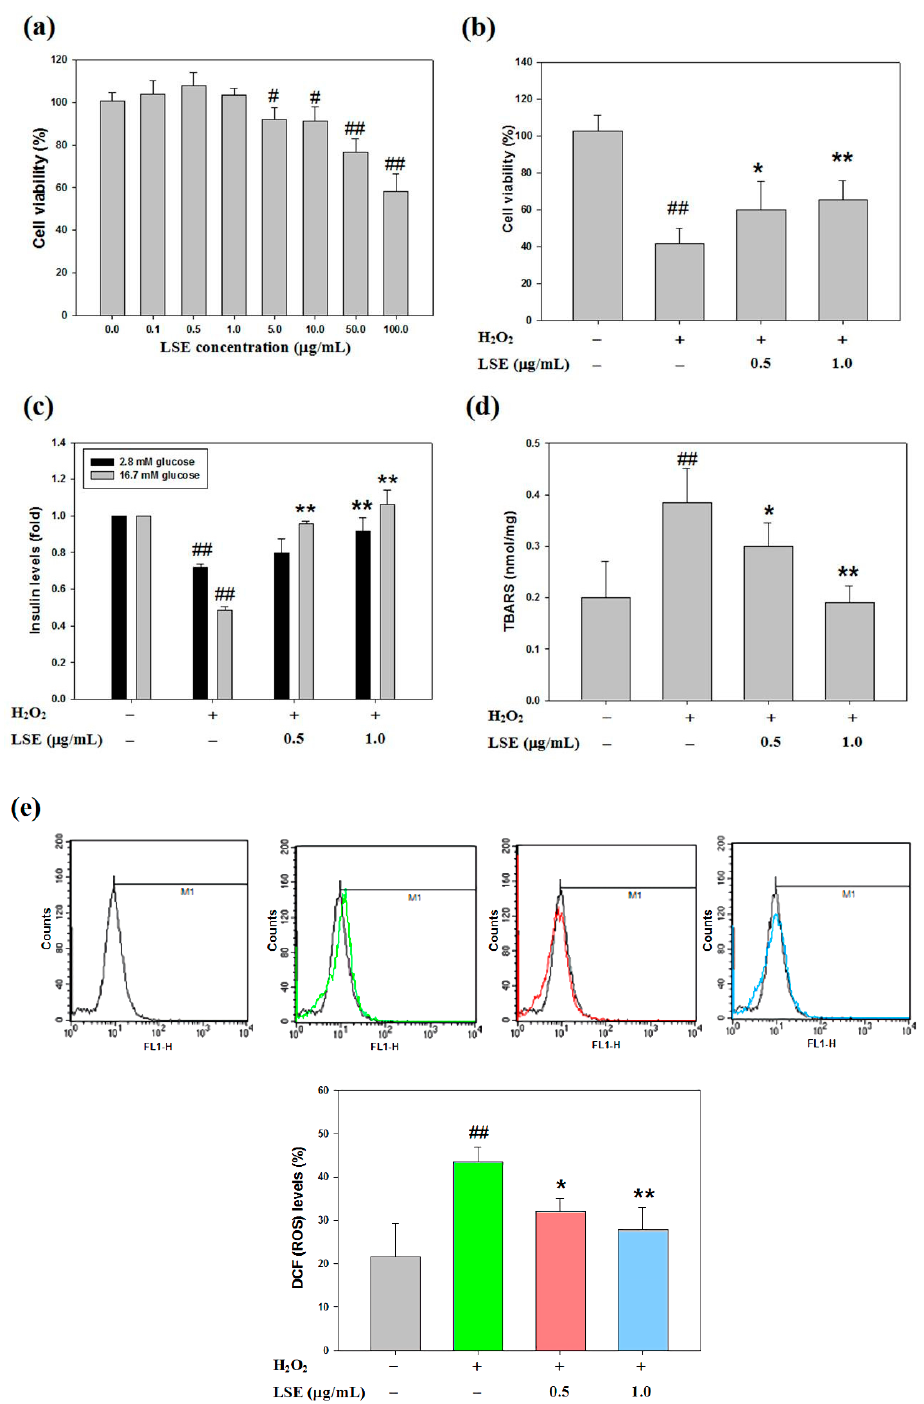
Figure 2. Effects of LSE in combination with H 2 O 2 on beta-cell viability and oxidative injury. ( a – b ) Rat pancreatic beta-cells (RIN-m5F) were treated with various doses of LSE (0–100 µg/mL) alone ( a ) or the indicated doses of LSE (0.5 and 1.0 µg/mL) in combination with 200 µM of H 2 O 2 ( b ) for 24 h. The cell viability was evaluated by the MTT method. ( c – e ) Under the same co-treatment conditions, the insulin secretion ( c ), lipid peroxidation ( d ), and intracellular reactive oxygen species (ROS) level ( e ) were assessed by measuring the glucose-stimulated insulin secretion (GSIS), thiobarbituric acid relative substance (TBARS), and dichlorofluorescein diacetate (DCFH-DA) assay, receptively. The results are represented as mean ± SD ( n ≥ 3) from three independent experiments. # p < 0.05, ## p < 0.01, compared with untreated control; * p < 0.05, ** p < 0.01, compared with the H 2 O 2 group.